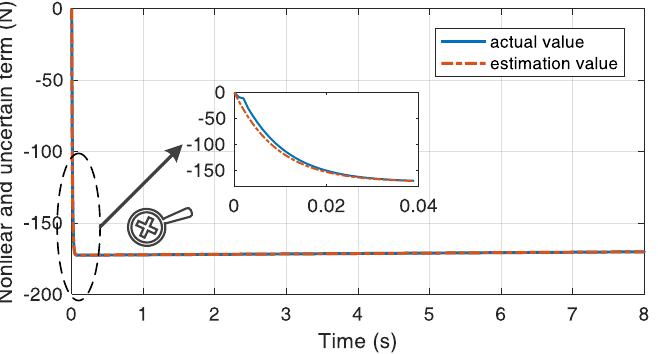
Figure 6. Estimation result for carriage 2 with the designed disturbance observer in case